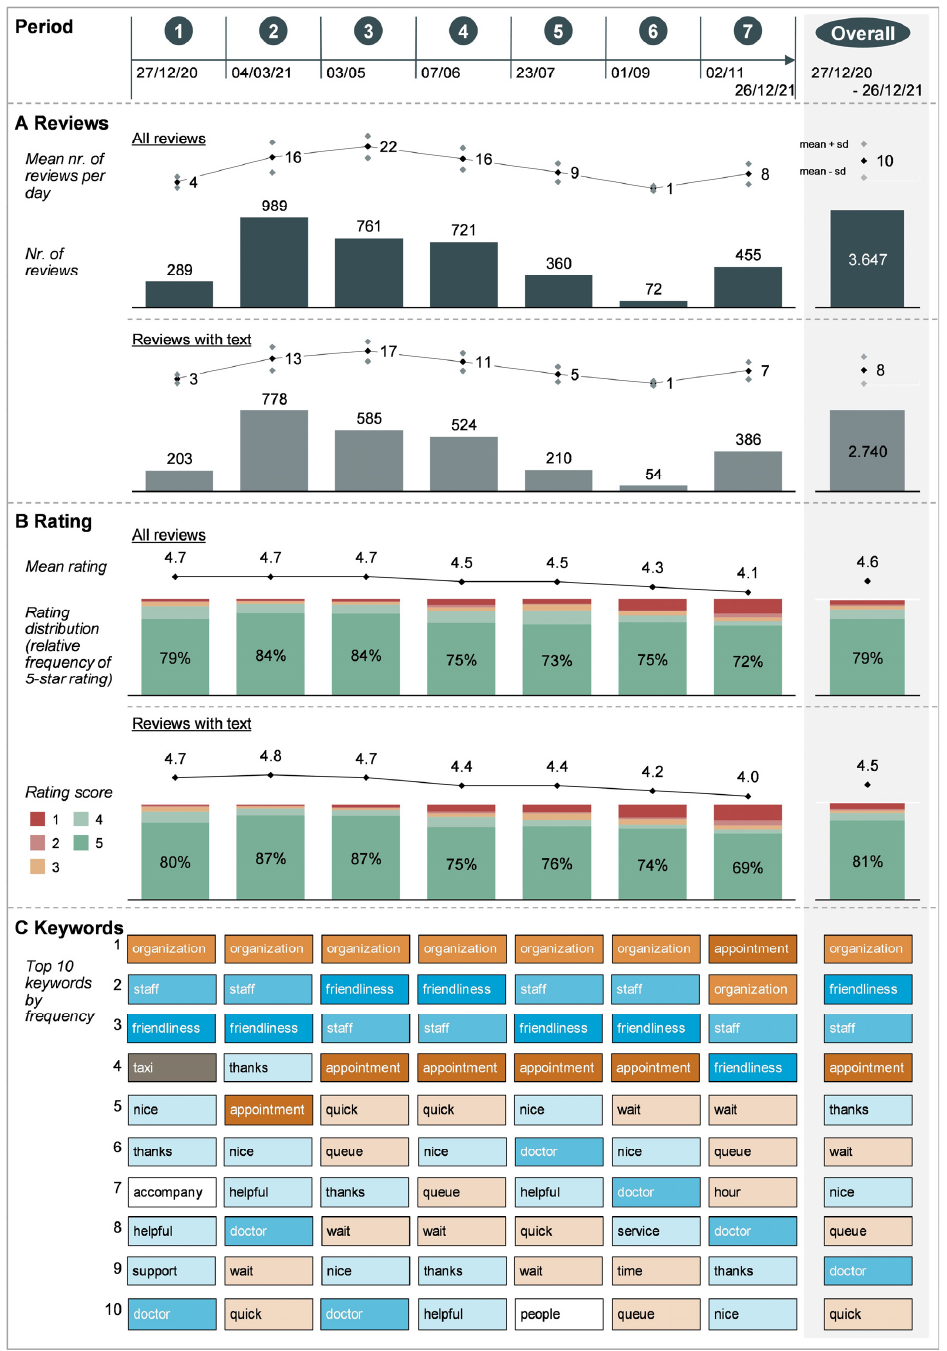
Figure 2. Number of reviews ( A ), review rating ( B ), and keywords ( C ) by time period and overall.